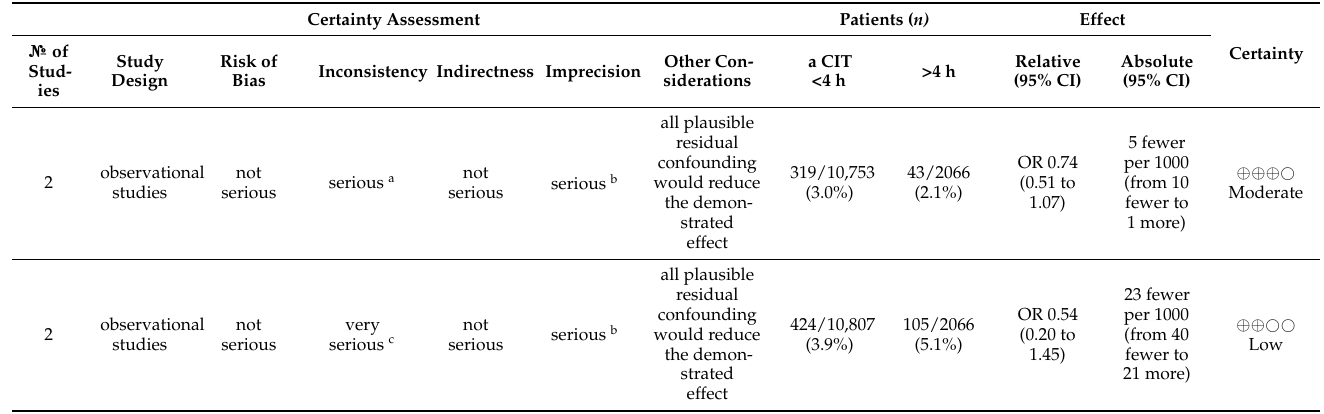
Table A4. Summary of findings with the level of evidence estimated by the Grade-tool for patient